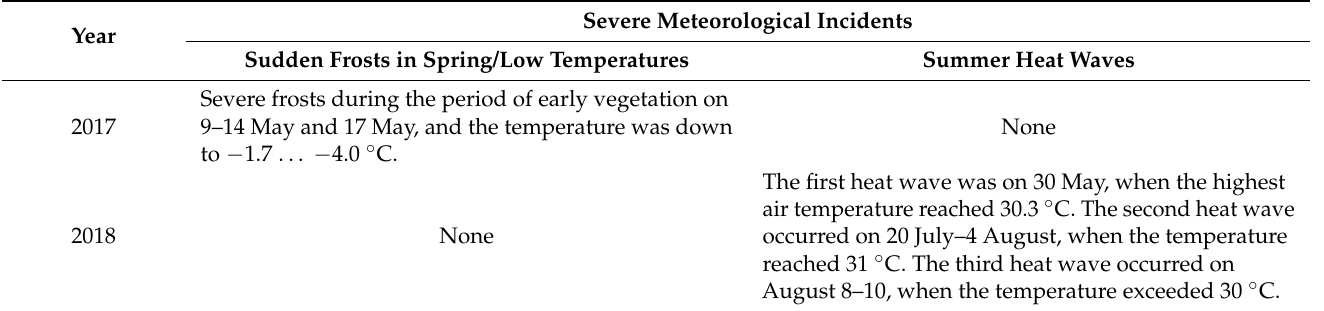
Table 6. Overview of severe meteorological incidents in the study years